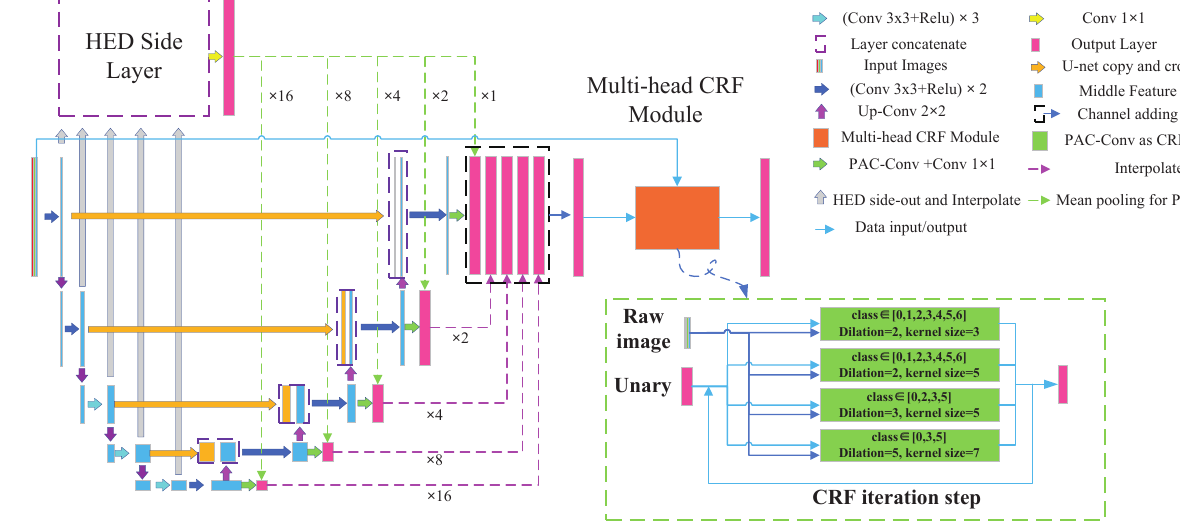
Figure 4. Inspection side-out CRF architecture. We improve Inspection-Net by pooling the output of the HED to the corresponding level size of the U-Net. Then, each pooling feature is the input of the guide layer of the PAC, and each level of the decoder is guided to output the segmentation results. Next, interpolate the results of each level and perform learnable weighting as the initial output